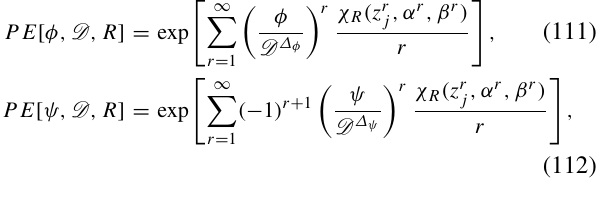
Table 2 2HDM: Quantum numbers of fields under the gauge groups and their spins under the Lorentz group. I = 1,2,3 and a = 1,2,…,8 correspond to SU ( 2 ) and SU ( 3 ) gauge indices respectively, and p = 1,…, N f denotes the flavor index. The color and isospin indices have been suppressed. L and R denote the chirality, i.e., the left or